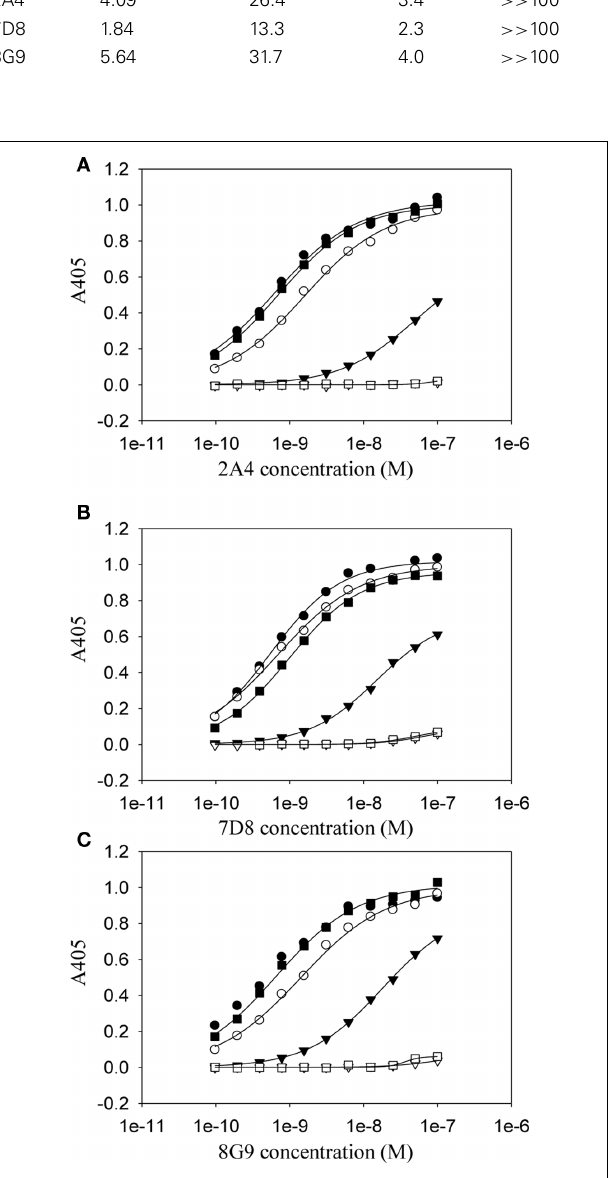
FIGURE 3 | Dependency on residues E73 and D74 for the high-affinity binding of anti-AA fibril-specific mAbs. Measurement by ELISA of the reactivity of mAbs 2A4 (A) 7D8 (B) and 8G9 (C) at different concentrations against microplate well adsorbed peptides ( (cid:3) , HEAT; (cid:4) , HEDA; (cid:5) ,